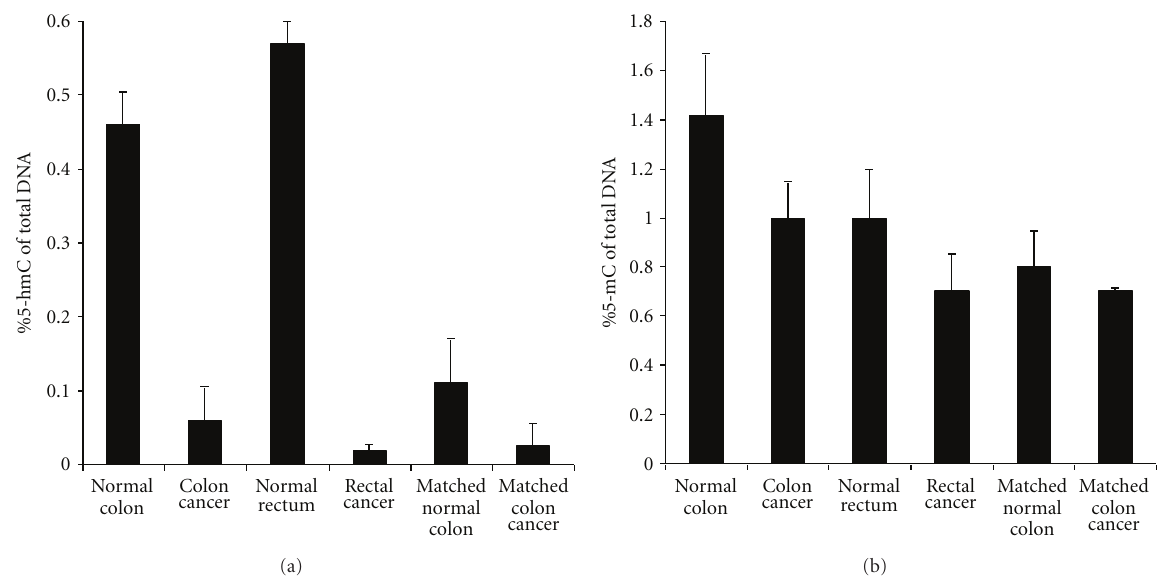
Figure 3: Contents of 5-hmC and 5-mC measured from normal colon and cancerous colon tissues. (a) 5-hmC contents. The data are average values ± standard deviation from 3 di ff erent assays. (b) 5-mC contents. The data are average values ± standard deviation from 3 di ff erent